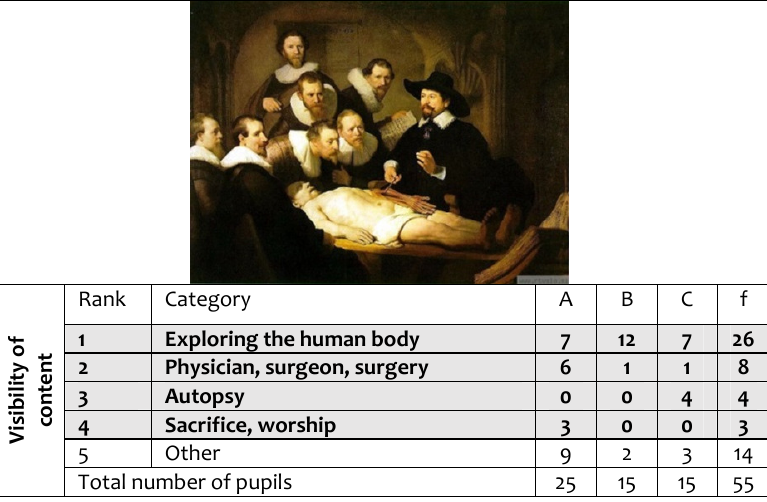
Table 6: Ranking order of the categories of answers regarding the visibility of the content of